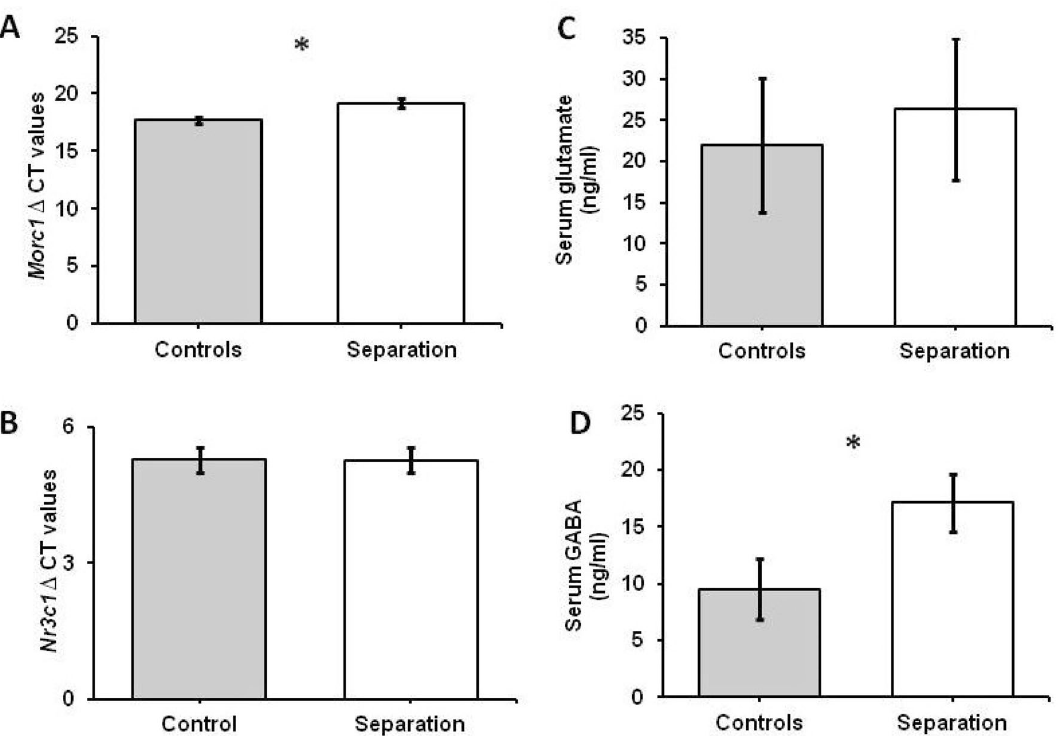
Figure 2. ( A ) Delta CT values of Morc1 mRNA analyzed in mPFC brain region. Separated dams were expressing significantly lower levels of Morc1 mRNA as shown in significant higher CT values. Means ± SEM are presented for n = 15 controls and n = 13 separated dams. *P < .01. ( B ) Delta CT values of Nr3c1 mRNA analyzed in hippocampus brain region. Means ± SEM are presented for n = 8 controls and n = 8 separated dams. ( C , D ) Serum analyses of neurotransmitters glutamate for n = 14 controls and n = 15 separated dams and GABA for n = 15 controls and n = 14 separated dams after MS. Separated dams showed higher concentrations of both neurotransmitters but only GABA demonstrating significant differences. Means ± SEM are presented. Data was analyzed using a One-Way